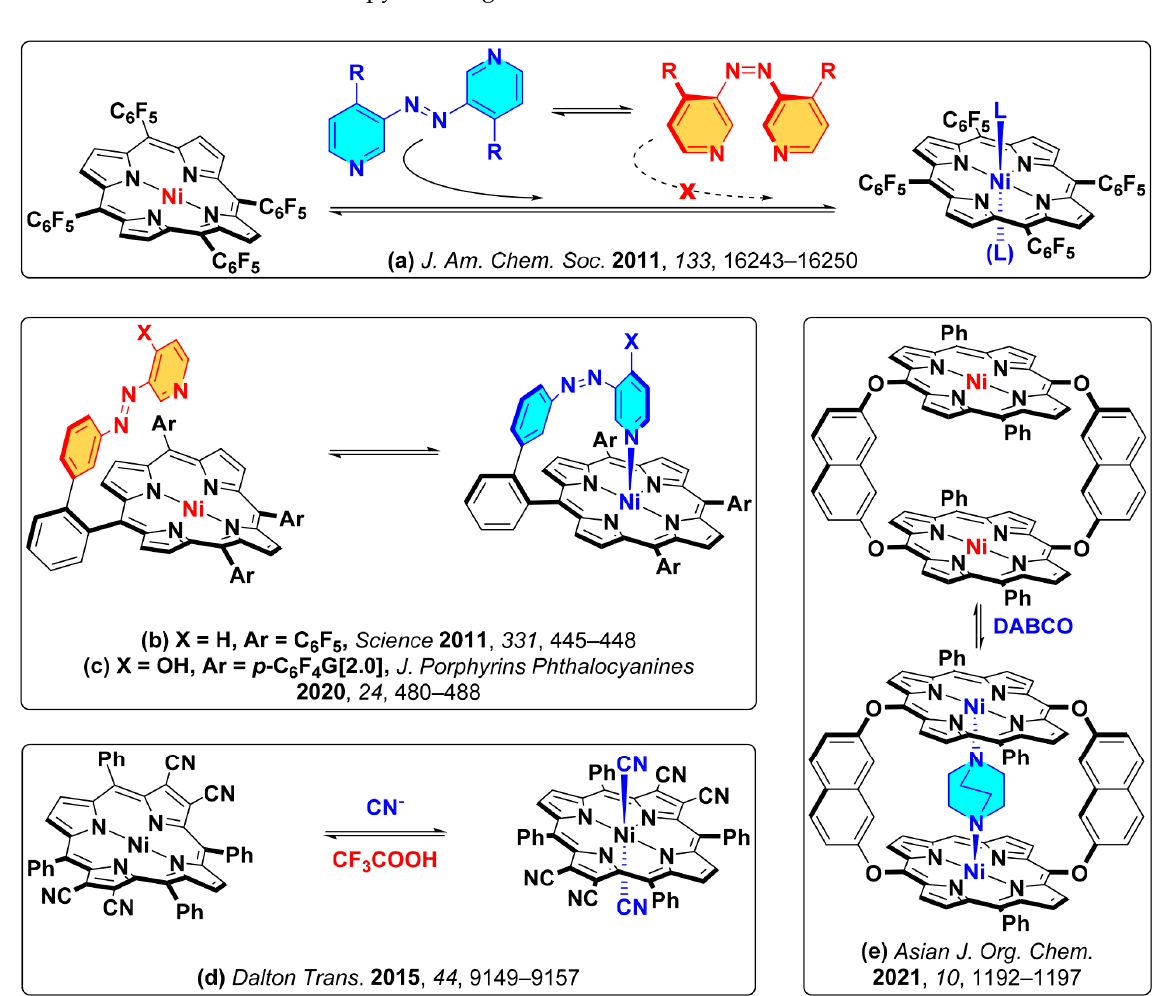
Figure 2. ( a ) coordination of photodissociable external ligands to Ni(II) tetra(pentafluorophenyl)porphyrinate [24]; ( b ) reversible light-induced magnetic switching of azopyridine functionalized Ni(II) porphyrin [25]; ( c ) pH-dependent spin switch, acting in aqueous solution; here G[2.0] stands for hydrophilic dendritic glycerol substituent [26]; ( d ) electron deficient Ni(II) porphyrinate, acting as a colorimetric “naked eye” selective sensor of CN − anions [27]; ( e ) cofacial Ni(II) porphyrin dimer exhibiting efficient binding of 1,4-diazabicyclo[2.2.2]octane with Ni(II) metal centers [28].